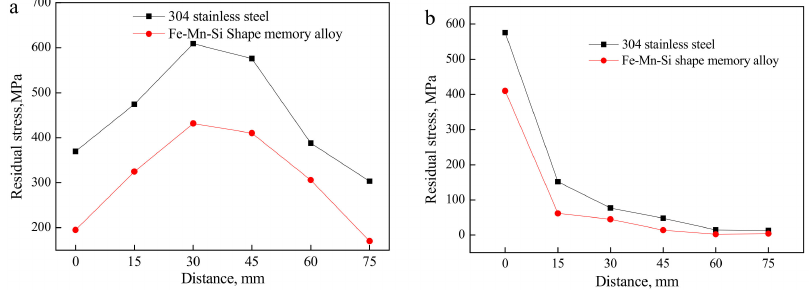
Figure 8. Distribution of residual stress inside laser welding specimen in directions ( a ) parallel and ( b ) perpendicular to the welding seam. Table 2. Strain value ε 1 , ε 2 , ε 3 and stress value σ of measuring points inside the specimen with 304 stainless steel welding seam.